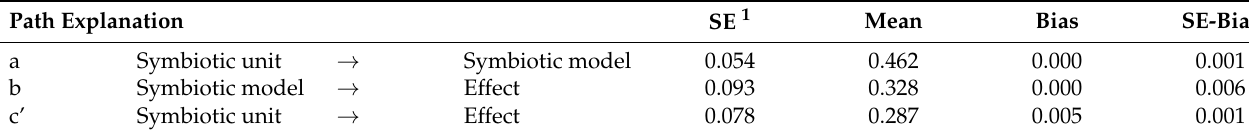
Table 9. Standardized estimates and standard error.